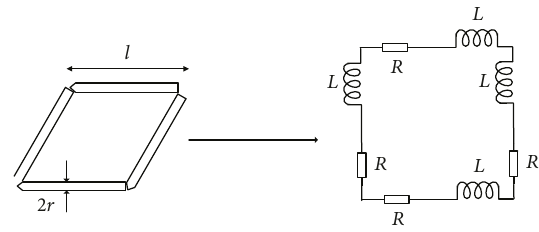
Figure 4: Parameter model of elementary grounding electrode segment.